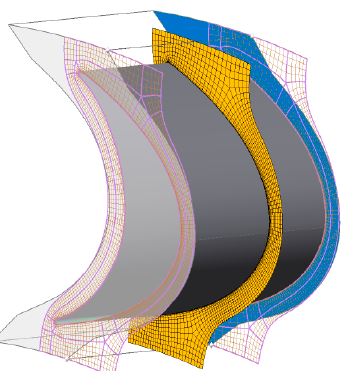
Figure 3. Blade mesh.